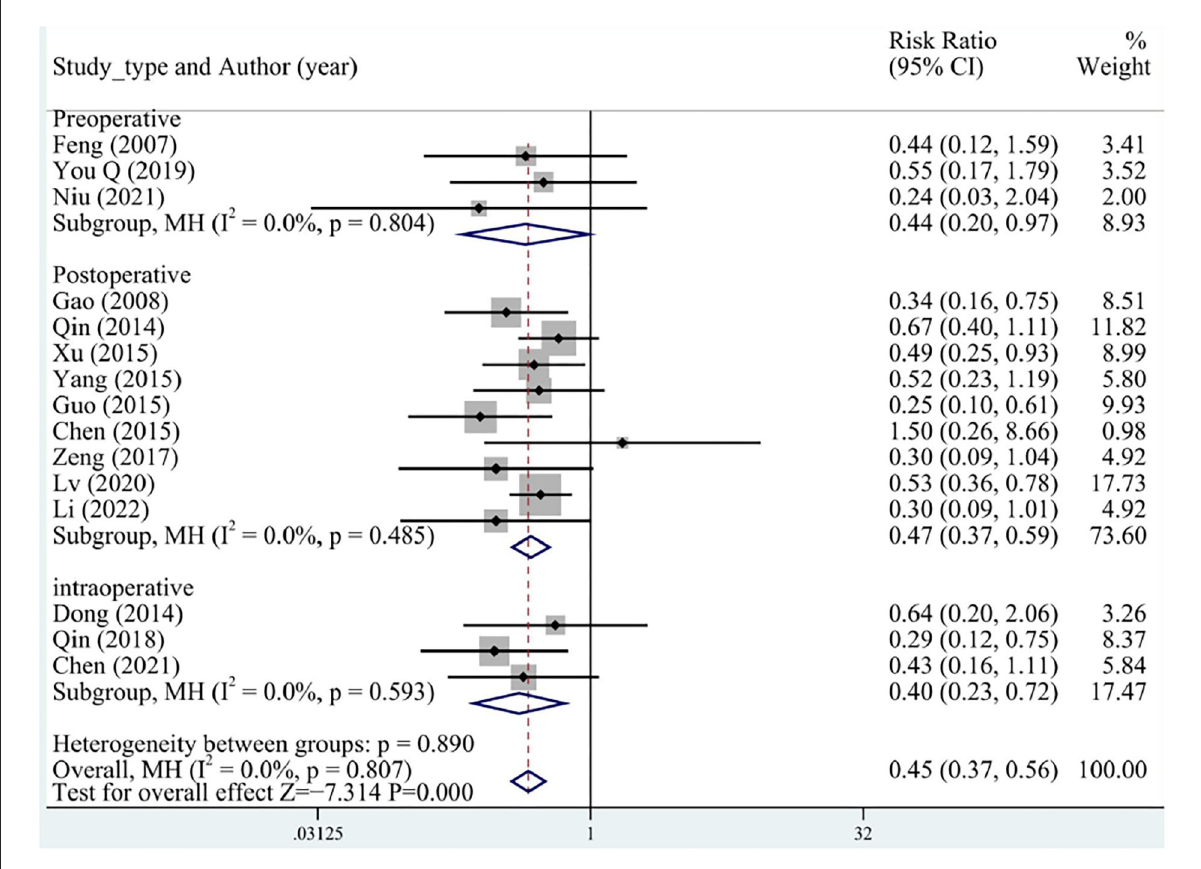
FIGURE3 MACE subgroup analysis. MACE, major adverse cardiovascular